Question: Sum up the contents of this chart in one sentence.
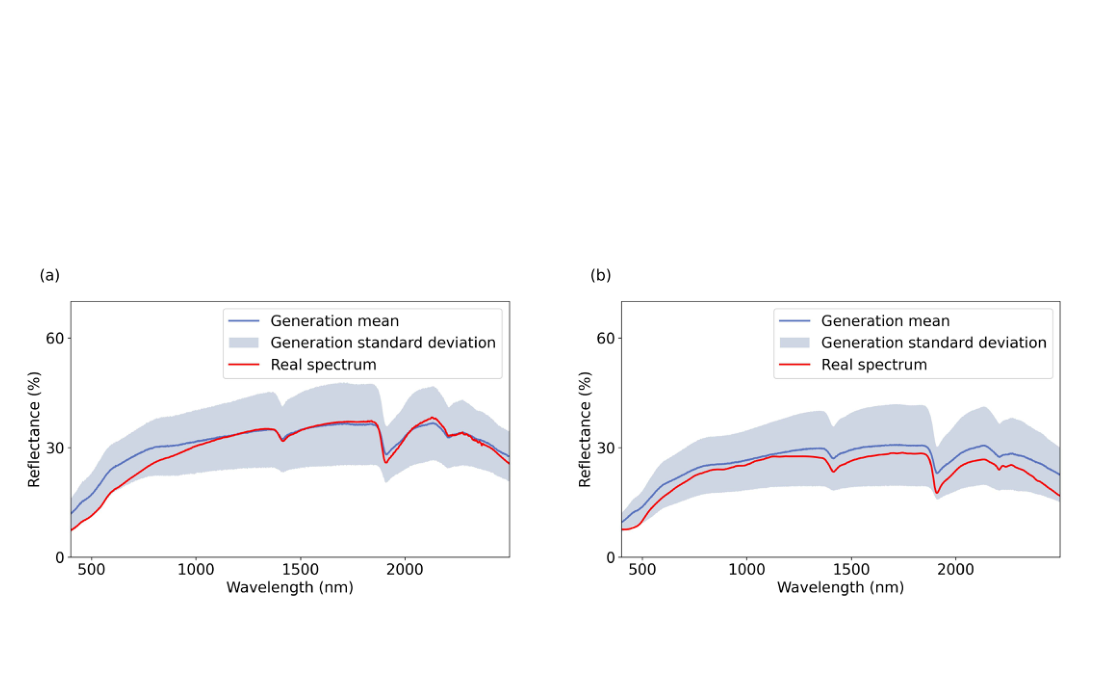
Answer: Variability in predicted soil reflectance spectra based on incomplete inputs. Real soil spectra are compared against the distribution of 10 generated spectra based on soil properties of (a) Spectrometer manufacturer: ASD, Clay: 45.7 %, Silt: 34.8 %, Sand: 19.4 %, Soil organic matter: 14.6 g/kg, CaCO3 content: 36 g/kg, Total iron content: 40700.0 mg/kg, Organic carbon content: 8.5 g/kg; (b) Spectrometer manufacturer: Spectral Evolution, Clay: 62.9 %, Sand: 20.0 %, Silt: 17.1 %, Bulk density: 1.036 g/cm3, Organic carbon content: 18.9 g/kg, Total nitrogen content: 1.57 g/kg.